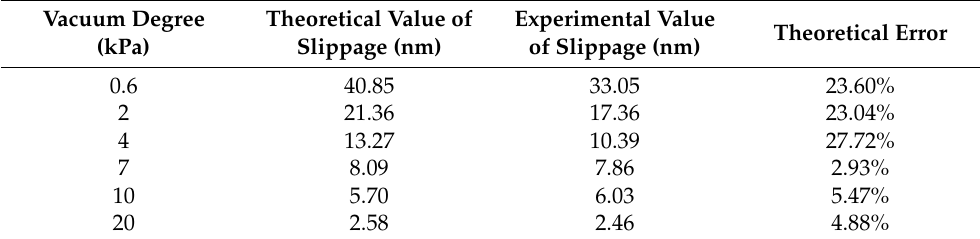
Table 4. Theoretical value, experimental value, and error of slippage (static to steady accelera- tion phase).